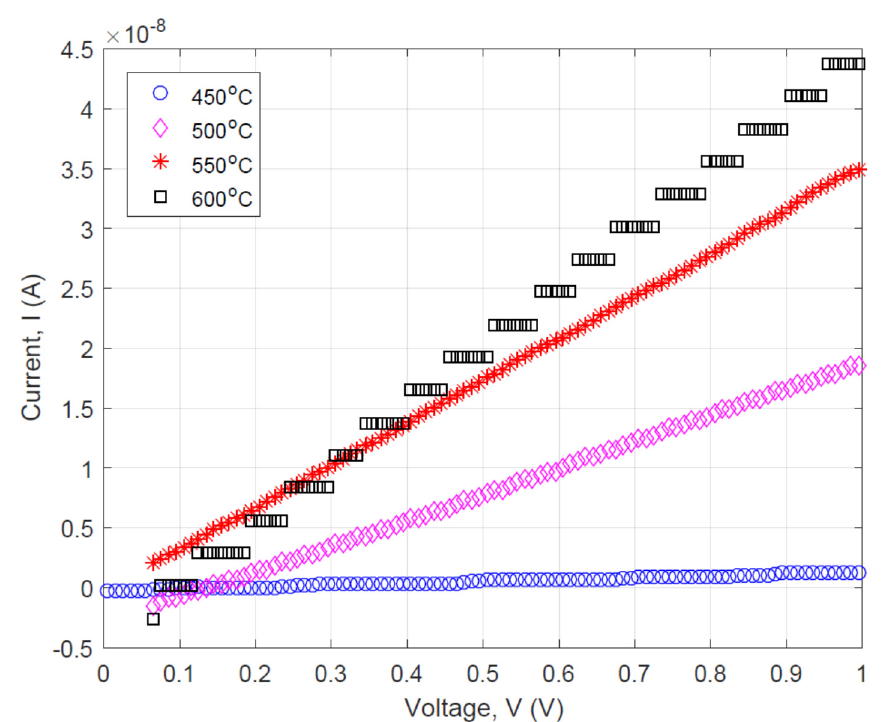
Figure 4. I–V relationship for specimens heat treated at 450 °C, 500 °C, 550 °C, and 600 °C revealing the conductance closes to that of an intrinsic semiconducting material such as Ge or Si.